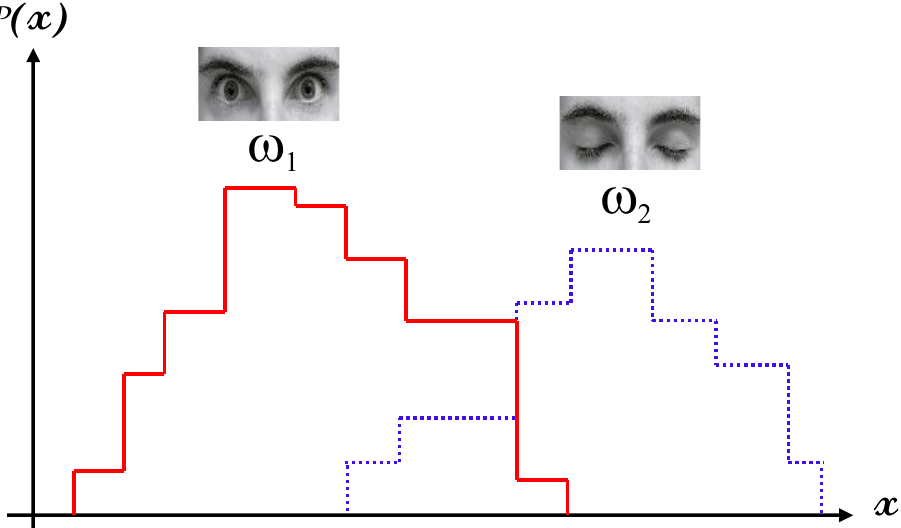
Figure 8. A histogram of feature values against their probability for two classes ω 1 and ω 2